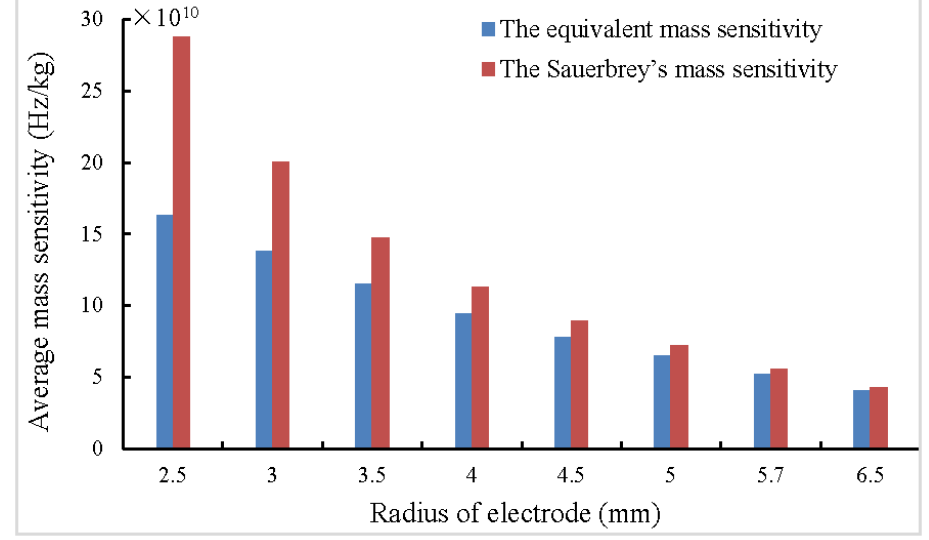
Figure 3. The equivalent mass sensitivities and the Sauerbrey’s mass sensitivity within electrode area of 5 MHz QCMs with different-sized electrodes.